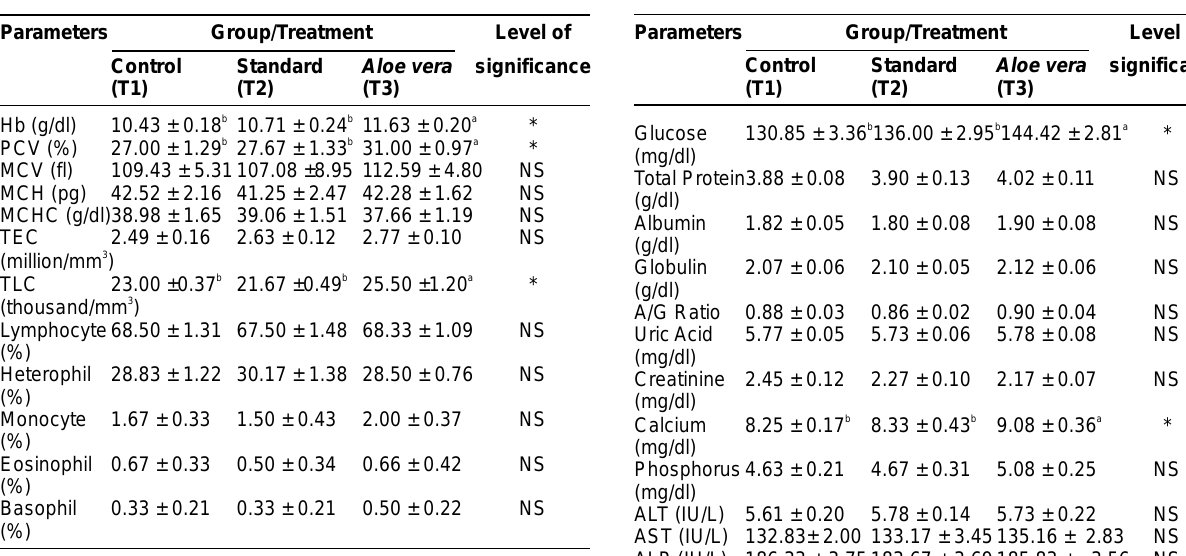
Table-3. Effects of supplementation of Aloe vera on Biochemical Parameters of broiler